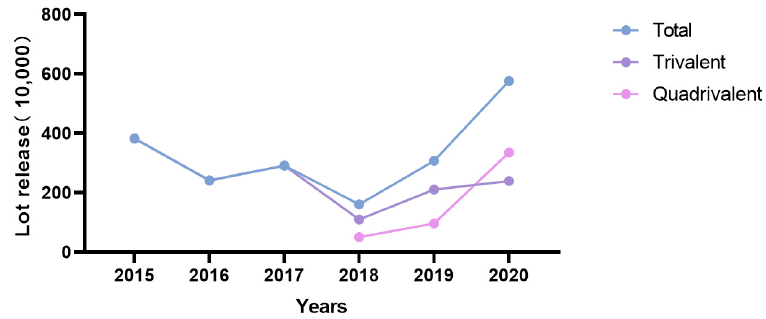
Figure 4. Batches of influenza vaccines issued in different years.